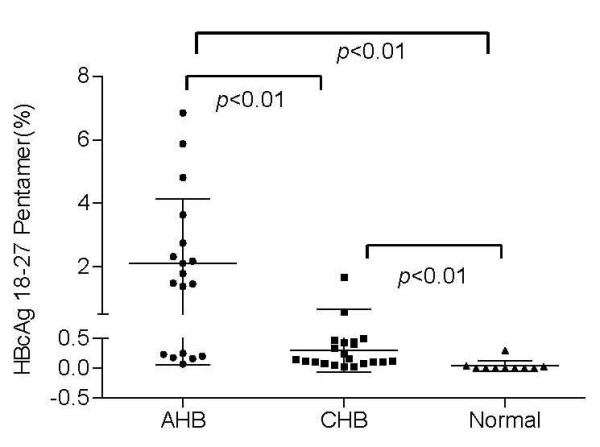
Frequency of HBcAg 18-27 epitope-specific CTLs. AHB indicated that the first HBcAg18-27 Pentamer test result after admission among the HLA-A0201-positive patients with acute hepatitis B; CHB indicated that the HBcAg18-27 Pentamer test result among the HLA-A0201-positive patients with chronic hepatitis B; Normal indicated that the HBcAg18-27 Pentamer test result among the HLA-A0201-positive subjects in the healthy control group. The differences among these groups were significant, p = 0.0 01.